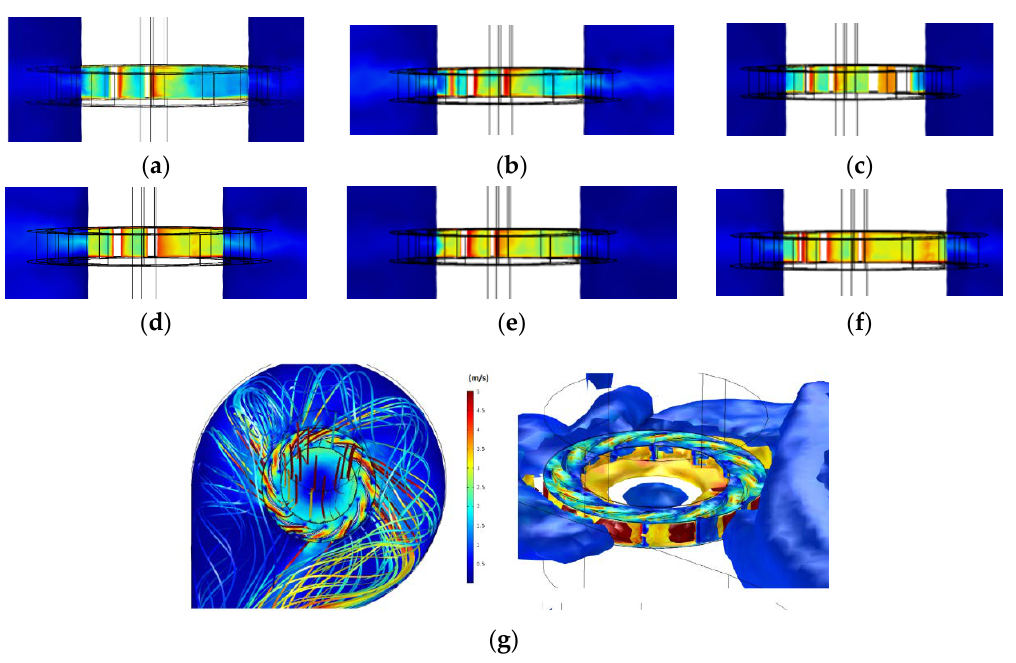
= 750 rpm; ( b ) = 1850 rpm; ( g ) general hori- N